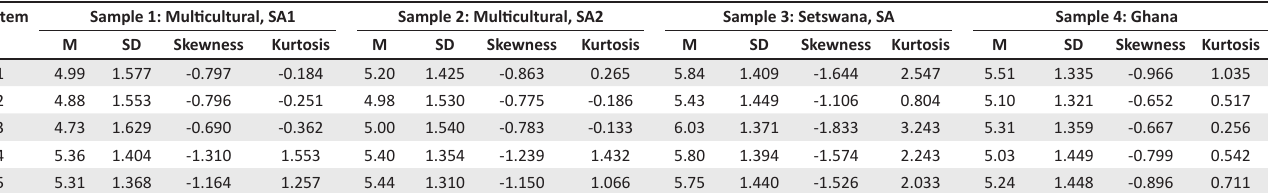
TABLE 1-A1: Descriptive Statistics of the Individual Scale Items of the HILS for Samples